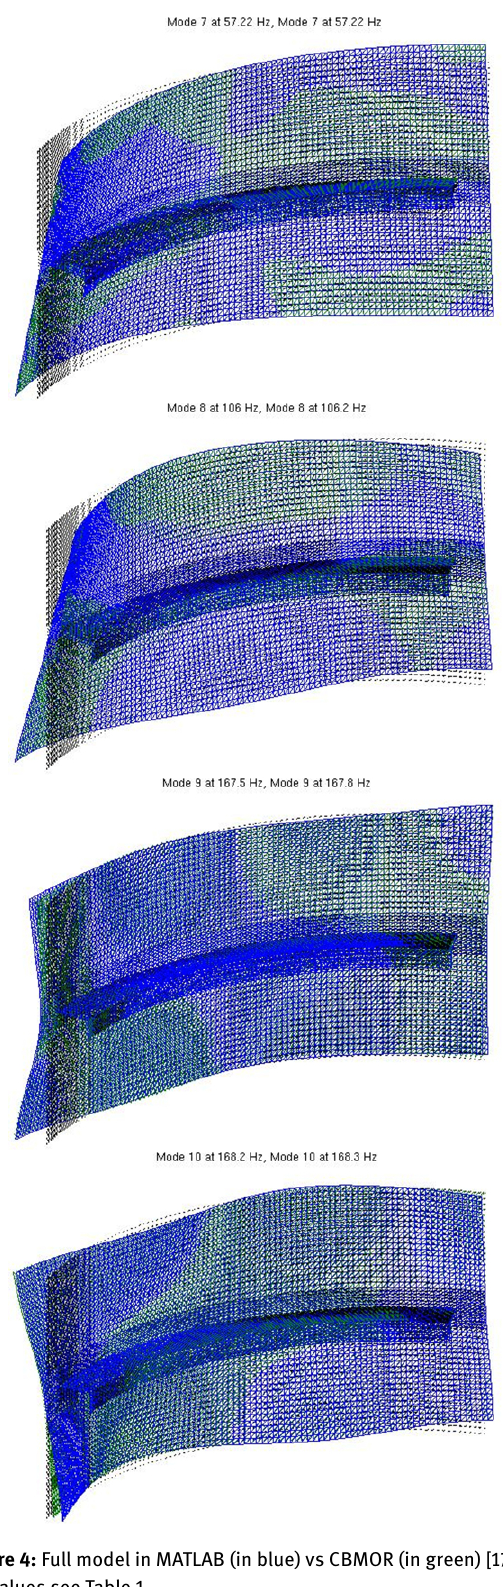
Figure 4: Full model in MATLAB (in blue) vs CBMOR (in green) [17], for values see Table 1.